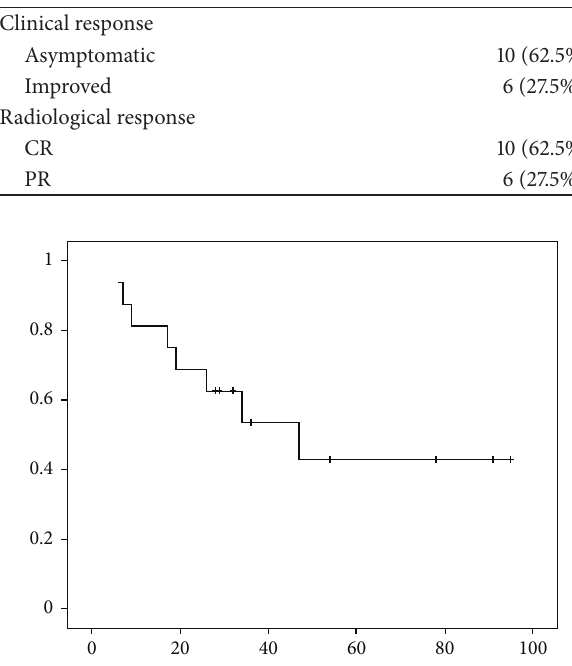
Table 3: Response evaluation at treatment completion.